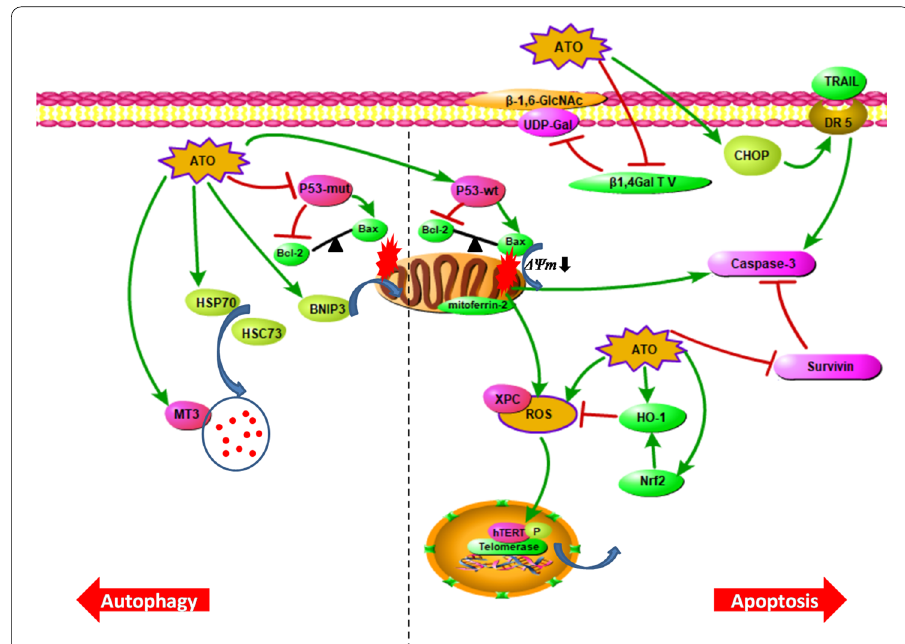
Fig. 1 The mechanisms of glioma cell death induced by arsenic trioxide. Apoptosis can be induced via external pathways and through internal pathways in glioma cell lines containing wild-type p53.